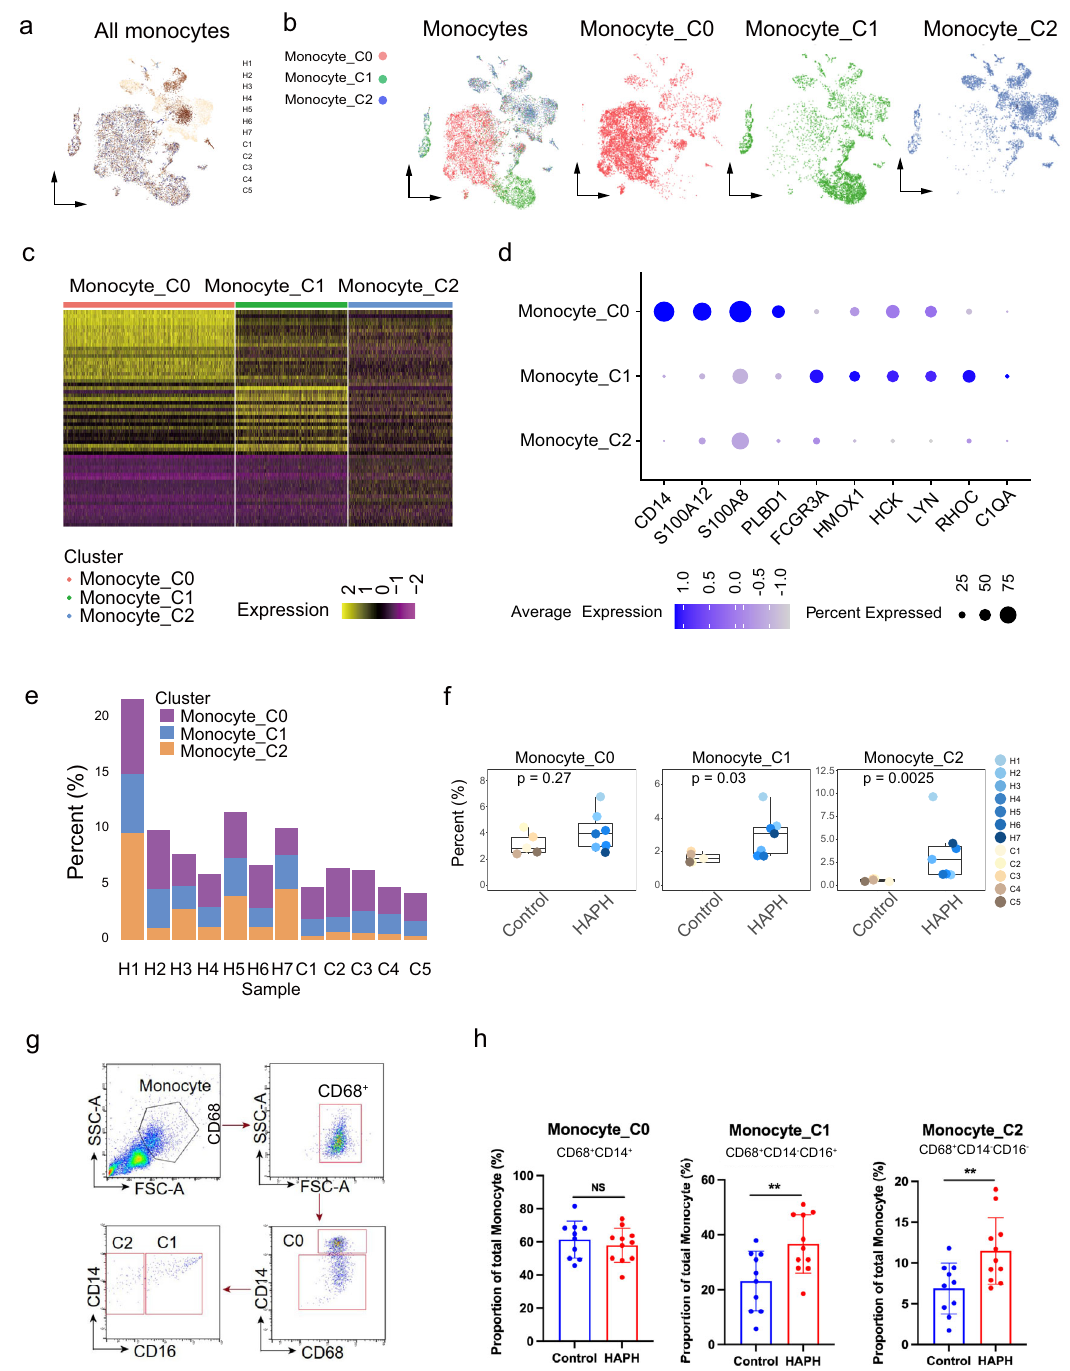
Fig. 3 | Expansion of monocyte clusters in circulation system of patients with HAPH. a t-SNE plotof all monocytes collectedin the present study. b t-SNE plot of all monocytes and the sub-clusters with cells colored based upon canonical gene markers of monocytes. clusters 0 (C0) represented as classical monocytes, C1 as non-classical monocytes and C2as intermediate monocytes. c Heatmap displaying the scaled expression values of discriminative gene sets from all monocytes in PBMCs between HAPH and controls. The top 50 marker genes in each subgroup were shown. d Violin plots indicating the expression of genes in each monocyte cluster in PBMCs from both HAPH and controls. e Proportions of each monocyte